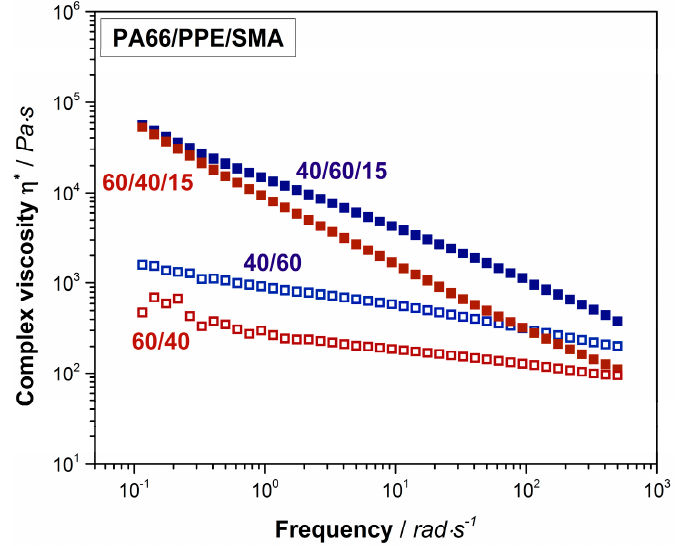
Figure 3. Shear rheological results of 60 / 40 (red hollow rectangular) and 40 / 60 (blue hollow rectangular) neat blends and their equivalents with 15 wt% SMA (red and blue rectangular).